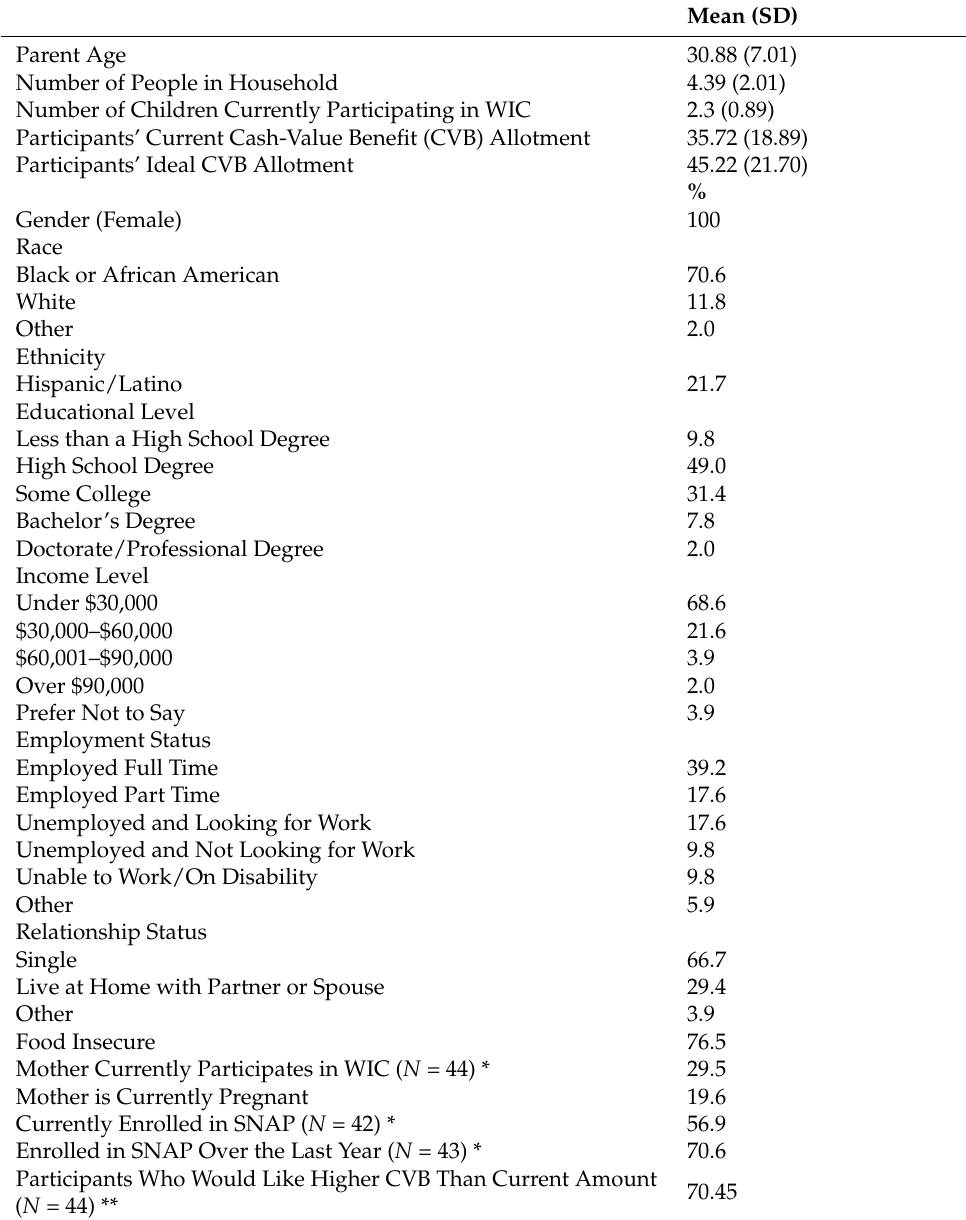
Table 2. Sample Characteristics ( N =